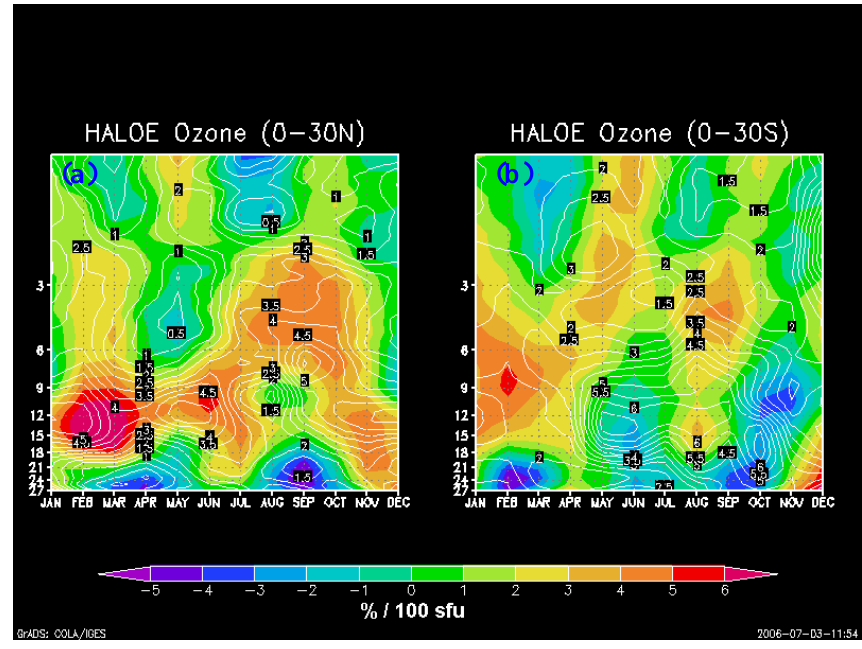
Fig. 3. Vertical distribution of the monthly variation of the solar coefficient (%/100 sfu) obtained from the HALOE ozone (a) 0–30 ◦ N (b) 0–30 ◦ S. Monthly variation of 1 sigma error (%/100sfu) in the solar effect on ozone is over-plotted with thin